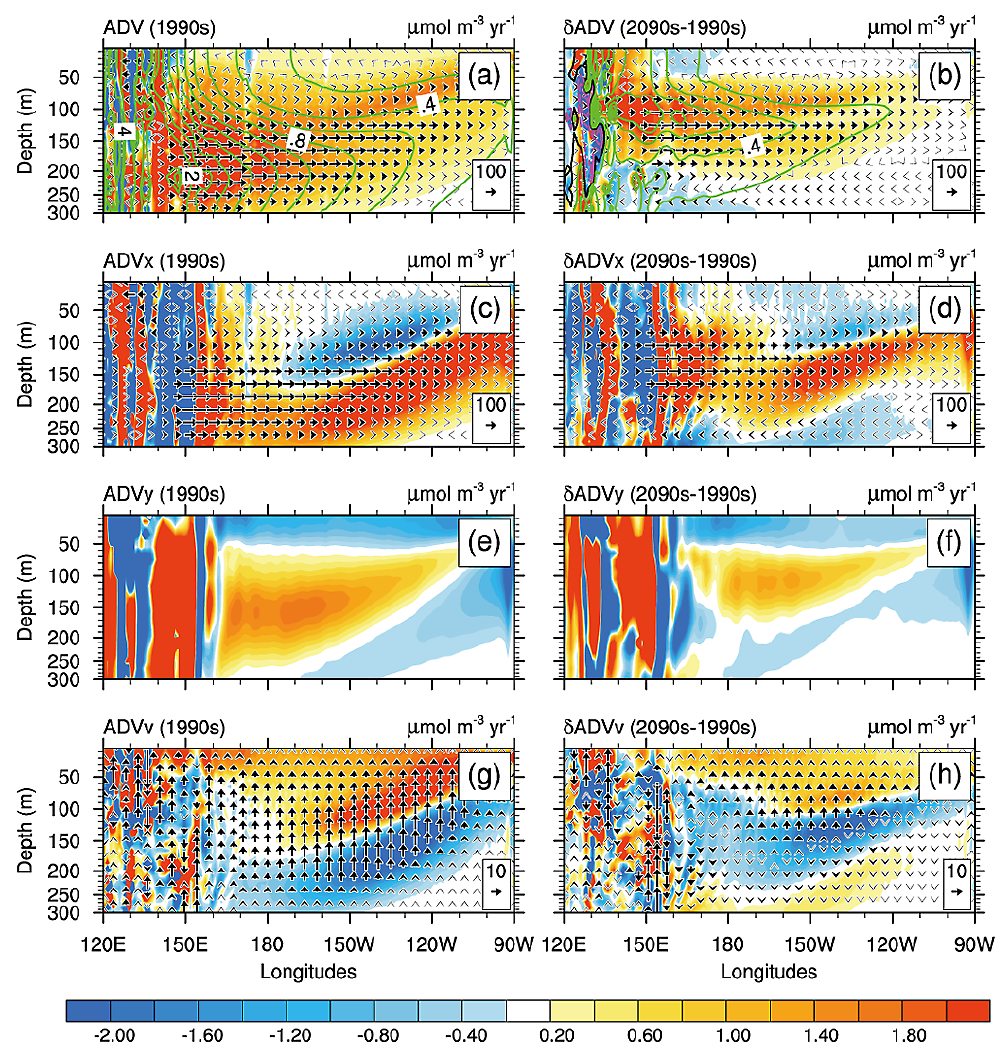
Fig. 8. Zonal cross sections of dissolved iron tendencies (color scale, µmolm − 3 yr − 1 ) in the equatorial Pacific (meridionally averaged over 5 ◦ S–5 ◦ N) for the ADV term in the 1990s (a) and the δ ADV term (b) . Vectors represent the iron flux on the x – z section (µmolm − 3 yr − 1 ) . Green, black, and magenta contours represent positive, zero, and negative dissolved iron concentrations, respectively. The contour interval is 0.2nM, except when the absolute value exceeds 2.0nM the contour interval is 1.0nM. Zonal ( c and d ), meridional ( e and f ), and vertical ( g and h ) components of ADV in the 1990s ( a , c , e and g ) and δ ADV ( b , d , f and h